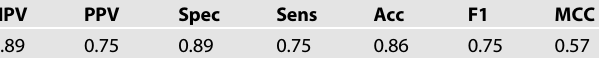
Table 6. Classi fi er performance measures for manic groups (mixed symptoms as target).